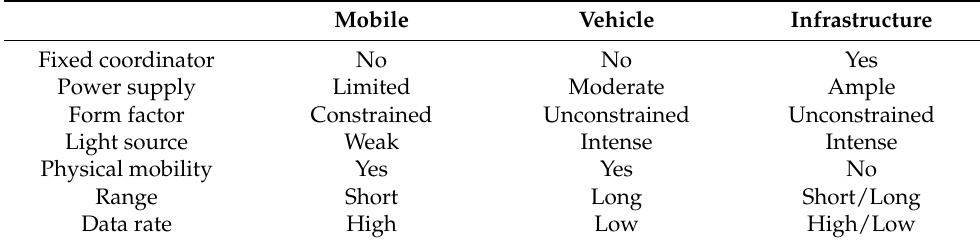
Table 5. Classification of IEEE 802.15.7